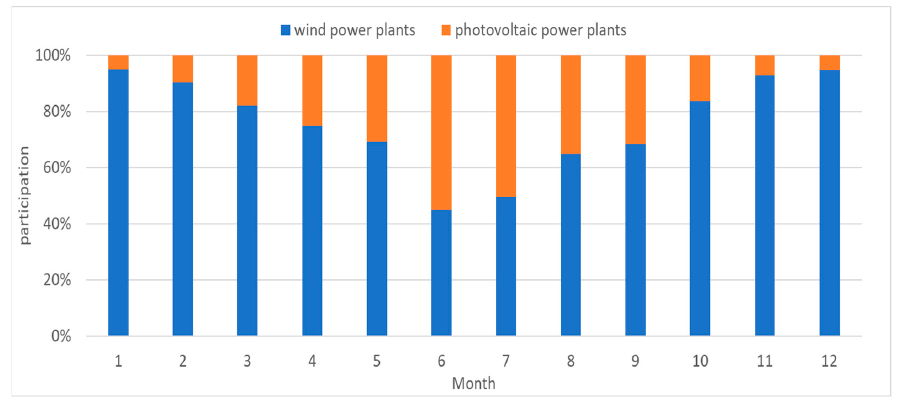
Figure 9. Share of photovoltaic and wind power plants in monthly generation of renewable energy sources in Poland in 2021 (own compilation of data from PSE S.A.).